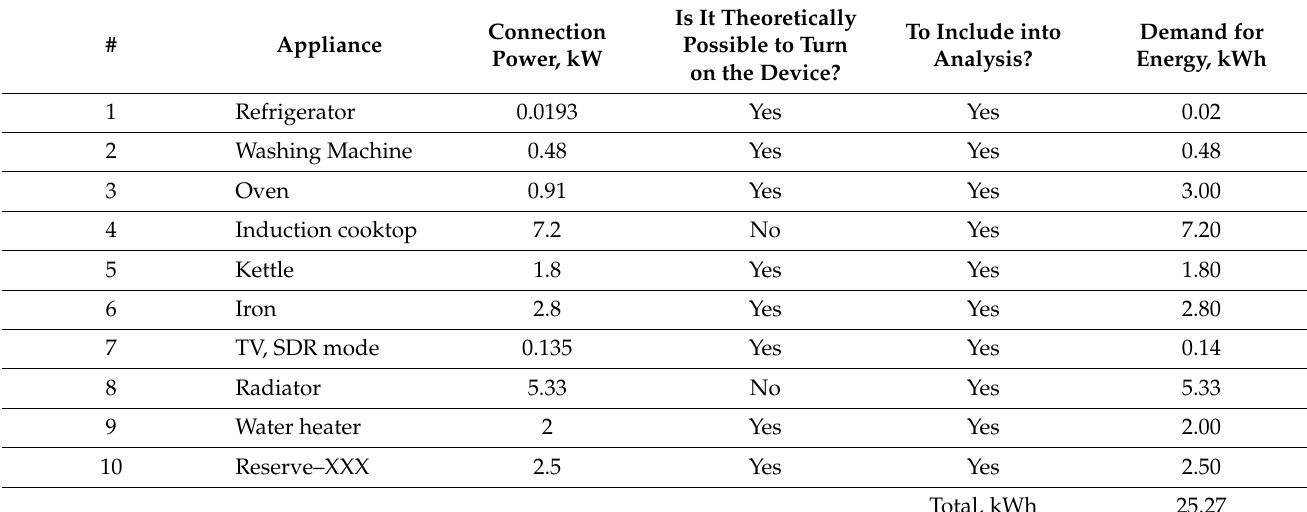
Table 14. Basic results of the energy performance evaluation of the designed photovoltaic system for the analyzed single-family house without considering the degradation